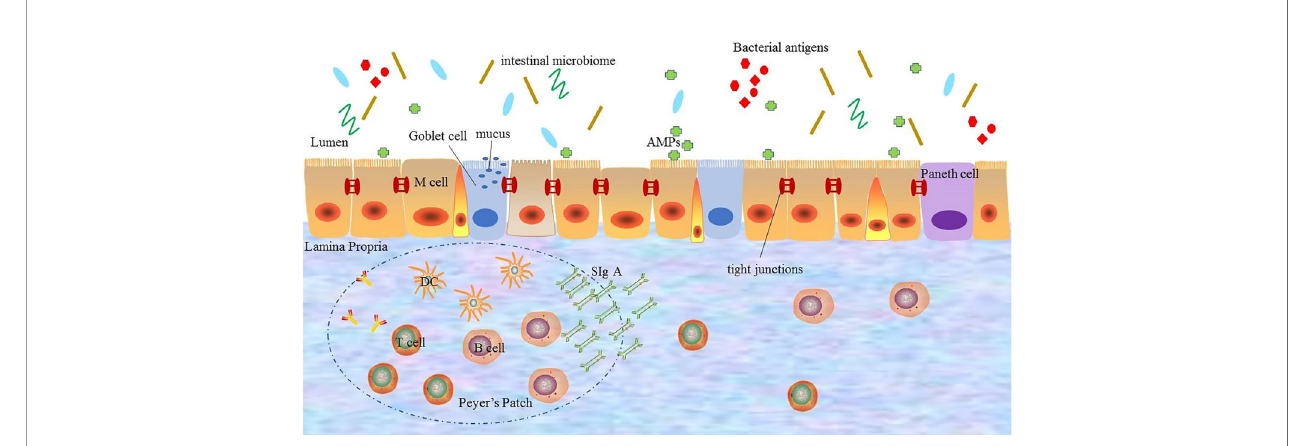
FIGURE 1 | The composition of the intestinal mucosal barrier. The intestinal mucosal barrier includes physical barriers, chemical barriers, immune barriers, and microbial barriers. Each barrier interacts with each other to perform barrier functions. DC: dendritic cell; AMPs: antimicrobial proteins; SIgA: secreted